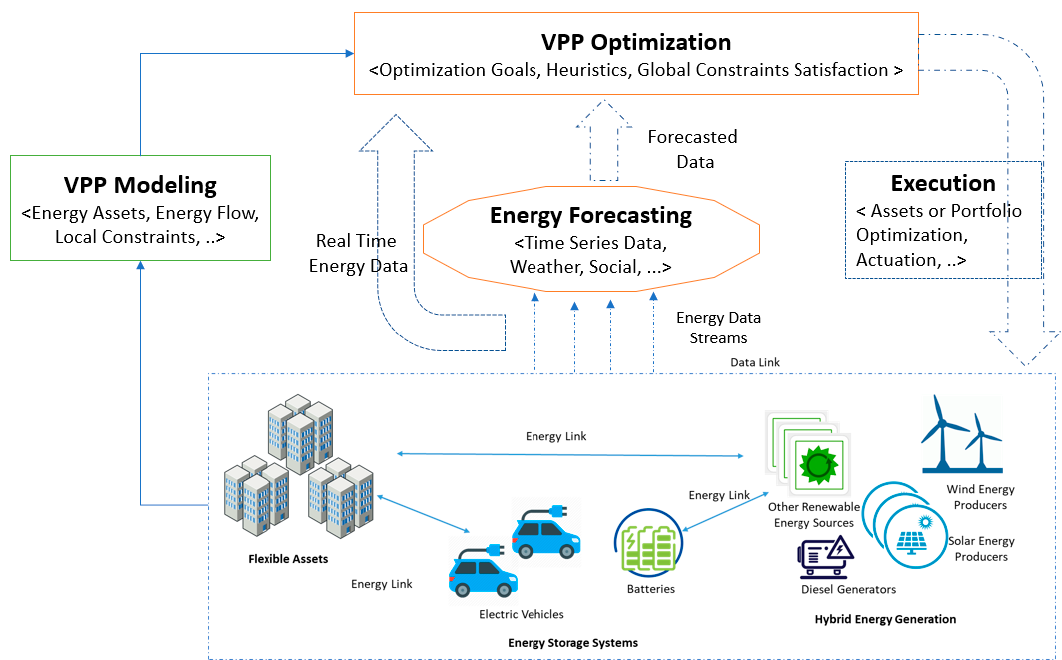
Figure 3. VPP concepts and technology usage.